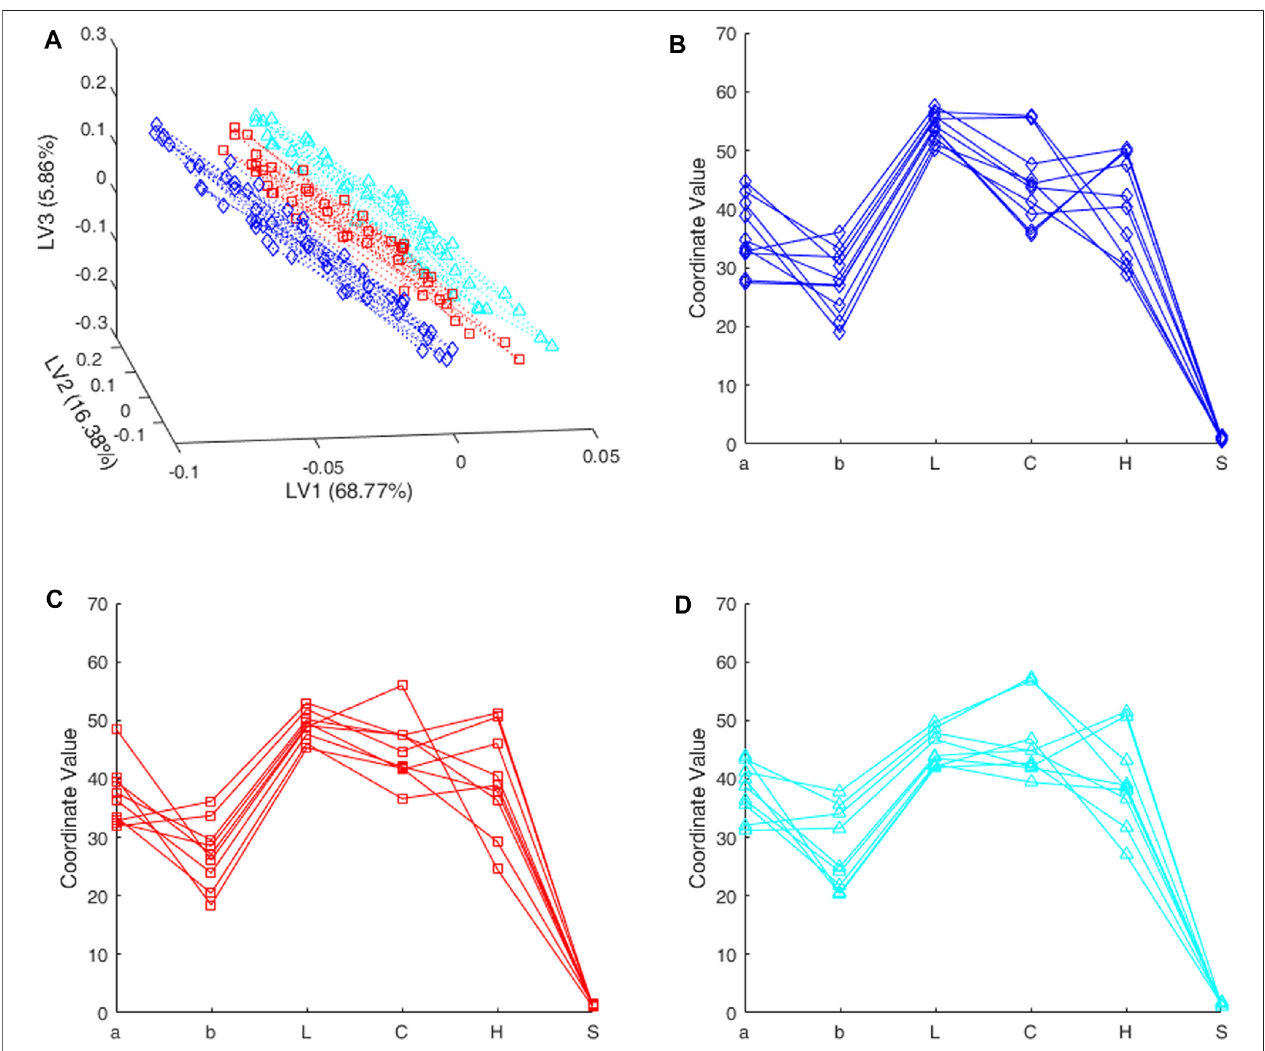
FIGURE 2 | Rioja wines. Boundary objects for different class-models (A) latent space (B – D) input space. Blue lines and rhombuses are for the class-model with sensitivity0.99and 0.89ofspeci fi city; redlinesand squaresare forthebalanced class-model withboth sensitivityandspeci fi cityequalto0.954; cyanlines and triangles are for the class-model with sensitivity 0.90 and 0.98 of speci fi